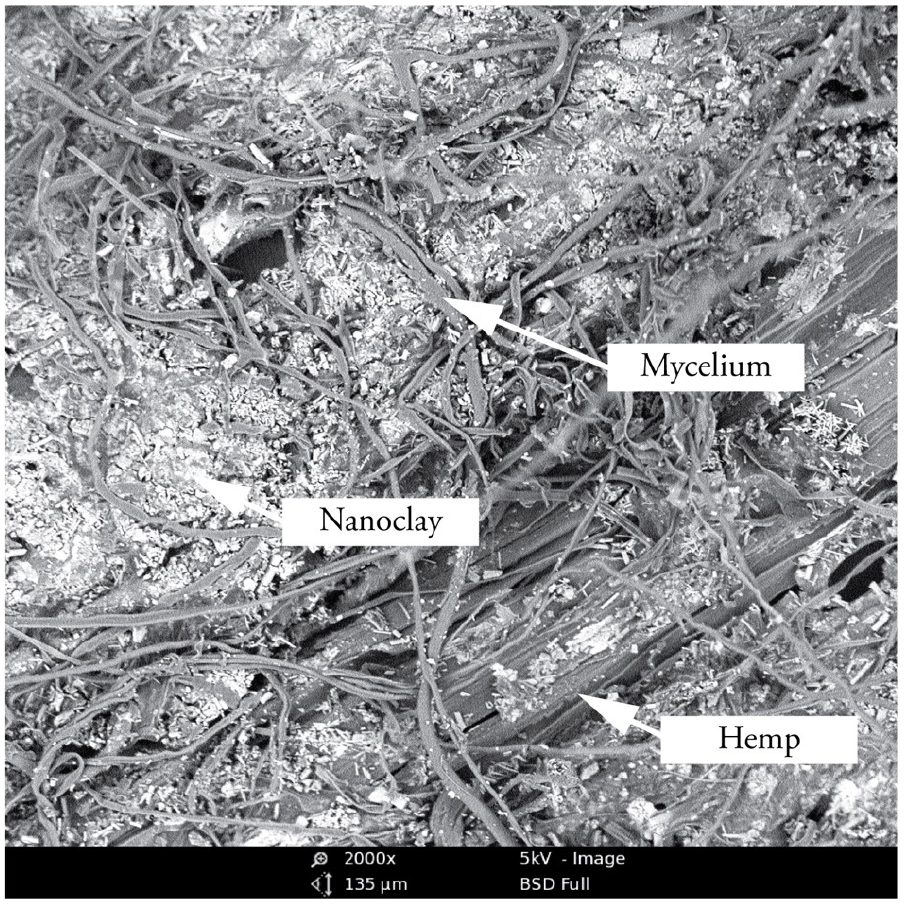
Figure 6. Micrograph of 2.5 wt.% nanoclay-mycelium composite showing the hyphae that grow inside the nanoclay, which is coated around the hemp fibers.